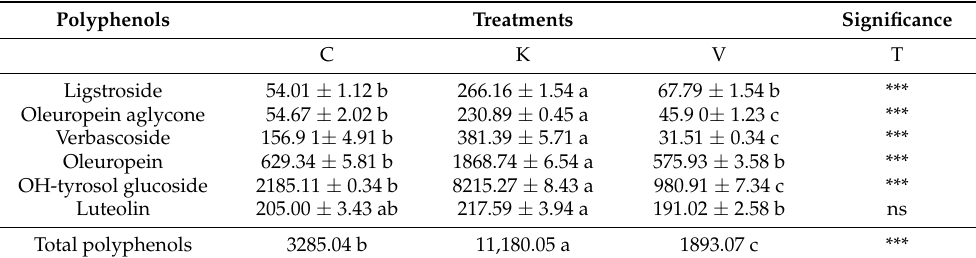
Table 3. Effect of kaolin (K) and 1-p-menthene (V) on phenolic compounds content in leaves of olive trees at the end of growing season. C: control. OH: